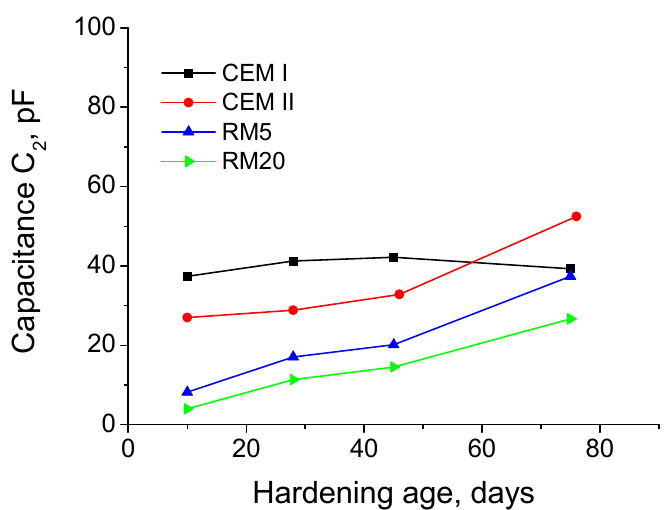
Figure 9. Results of impedance spectroscopy capacitance C 2 for CEM I, CEM II, RM5 and RM20 mortars.